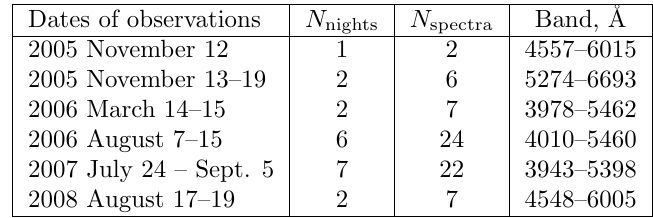
Table 1. Spectroscopic observations of Cyg X-1 with the 6 m telescope. Dates of